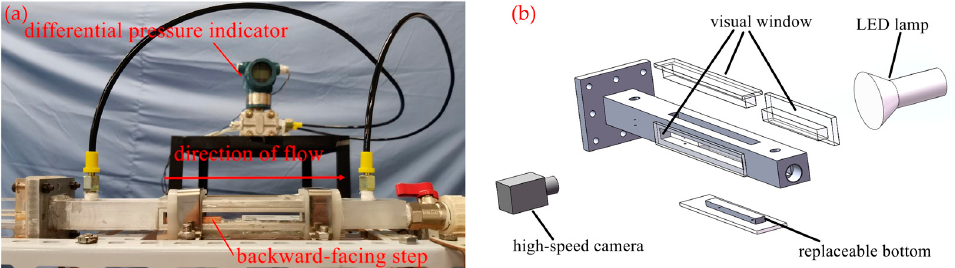
Figure 3. Test section. ( a ) Physical map; ( b ) Schematic diagram.